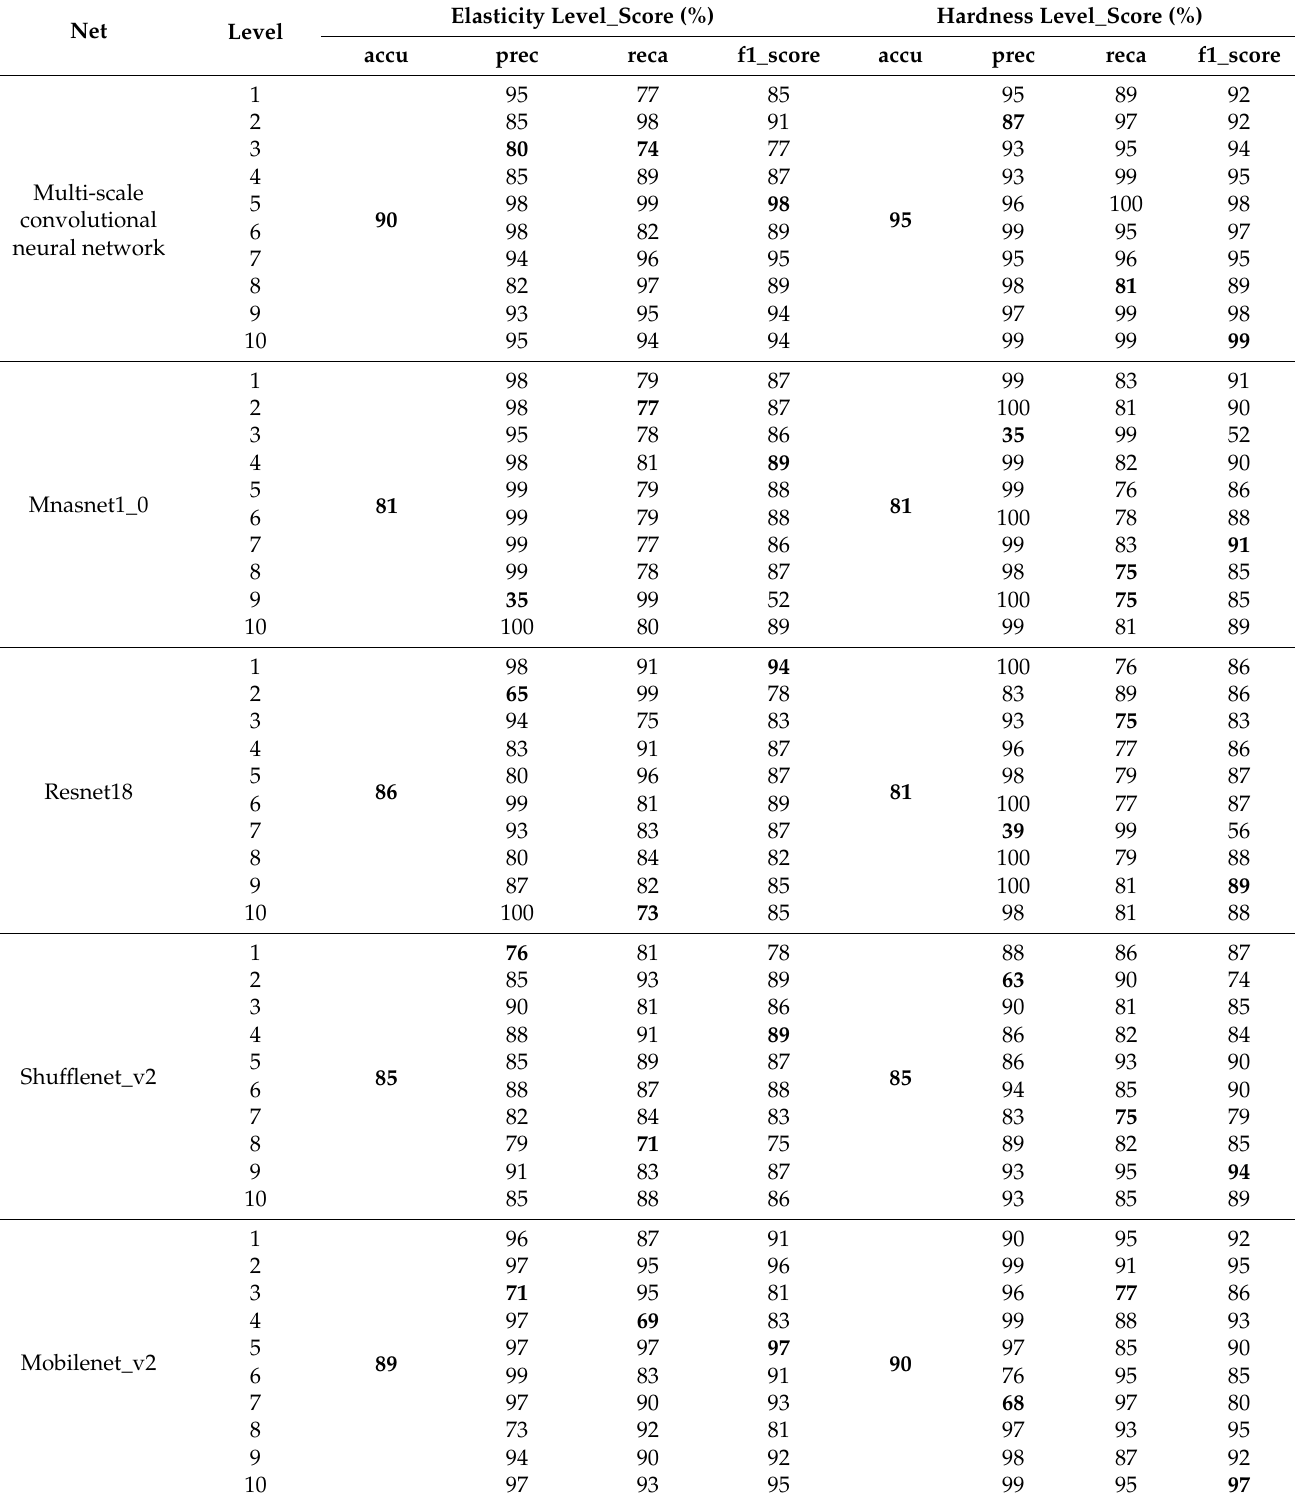
Table 2. Accuracy, precision, recall, and f1_score of elasticity and hardness strength levels of the five models, and the best or worst result shown in